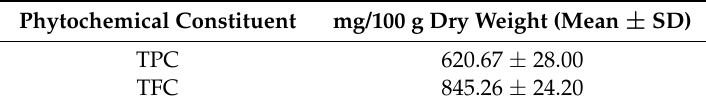
Table 2. Quantitative phytochemical constituents of aqueous extract of G. sessiliforme .